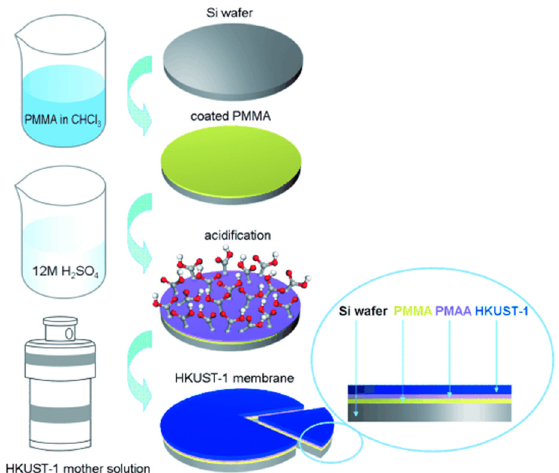
Figure 2. Schematic illustration of the preparation procedure for the free-standing HKUST-1 membrane. Reprinted with permission from [45], Copyright (2012) John Wiley and Sons publications.